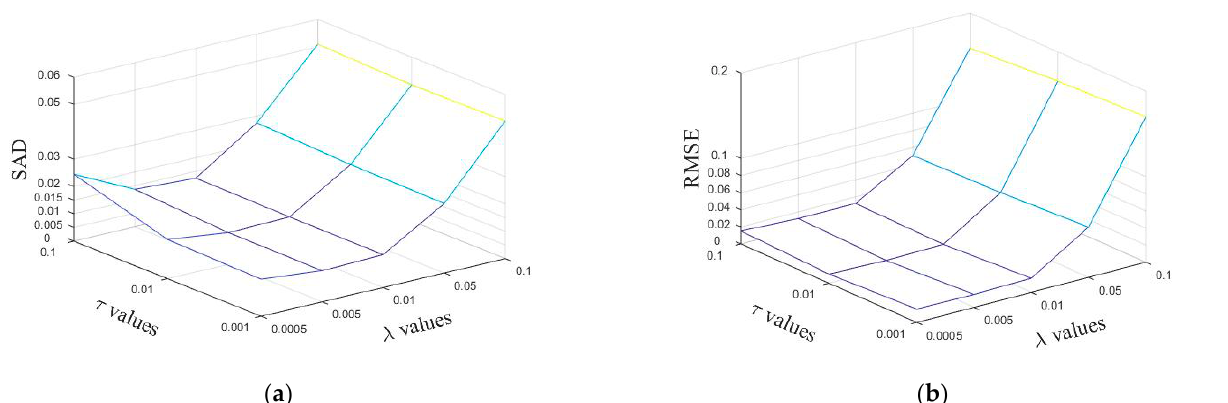
Figure 2. Spectral signatures used to generate the simulated data and abundance map of end member, 1–4. 1–4.